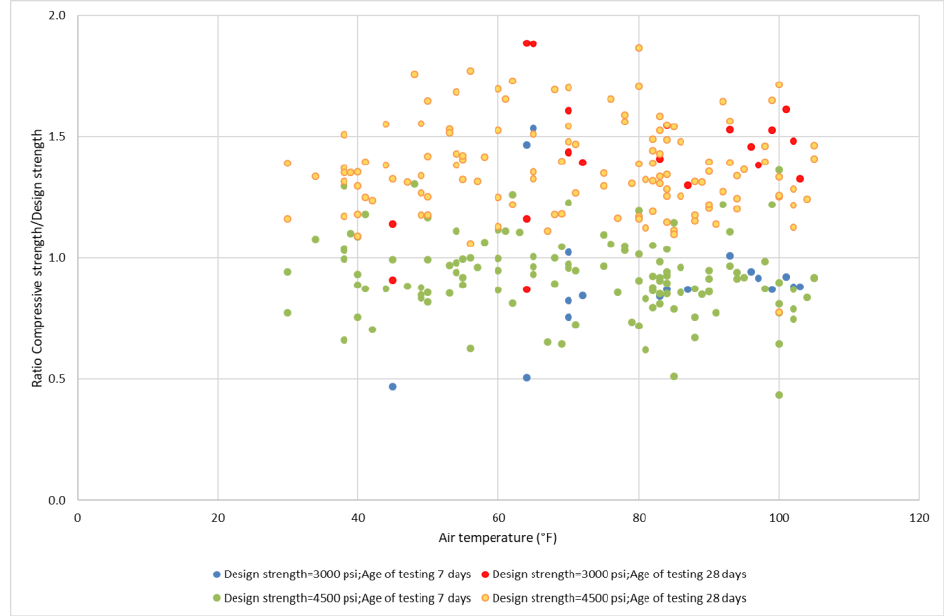
Figure 5. The relationship between the ratio of compression strength to design strength and air temperature with respect to design strength.